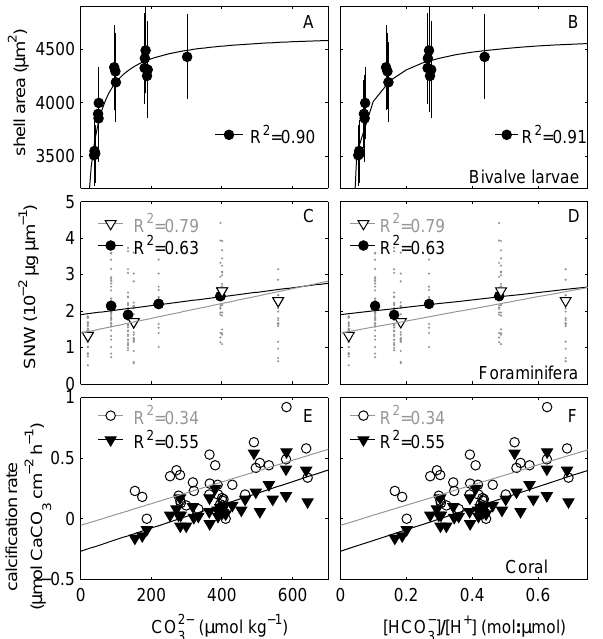
Figure 2. Correlations between calcification-related measurements and [CO 2 − ] (left panel) or [HCO ] / [H + ] (right panel). Panels 3 3 (a, b) : shell areas of D-veliger larvae reached 3 days after incu- bating embryos of the Pacific oyster Crassostrea gigas (Gazeau et al., 2011). Panels (c, d) : size-normalized weight (SNW) of the foraminifer Ammonia sp. in its asexually reproducing life cycle stage (Keul et al., 2013). Black dots: constant DIC, variable CO 2 . White triangles: constant pH, variable CO 2 . Panels (e, f) : calcifica- tion rates of the symbiont-bearing hermatypic coral Acropora eu- rystoma (Schneider and Erez, 2006). White dots and black triangles refer to incubations in light and darkness, respectively.